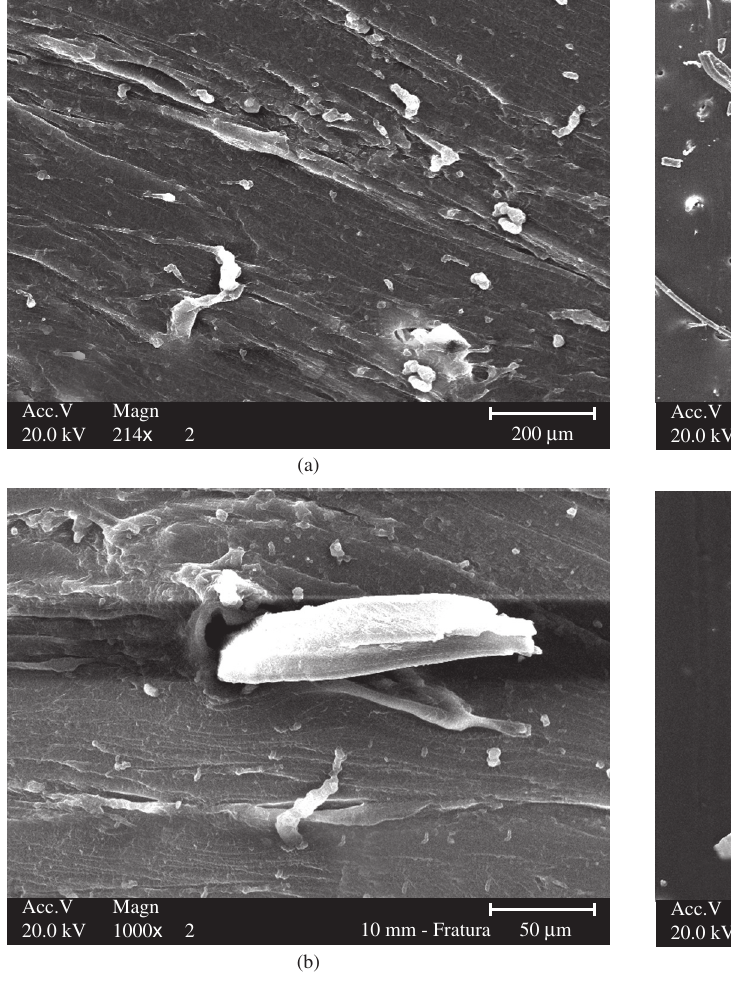
Figure 3. Scanning electronic micrographs of SBS/5% short sisal fiber com- posites processed in a double-screw extruder: a) short magnification and b) higher magnification – fiber detail.